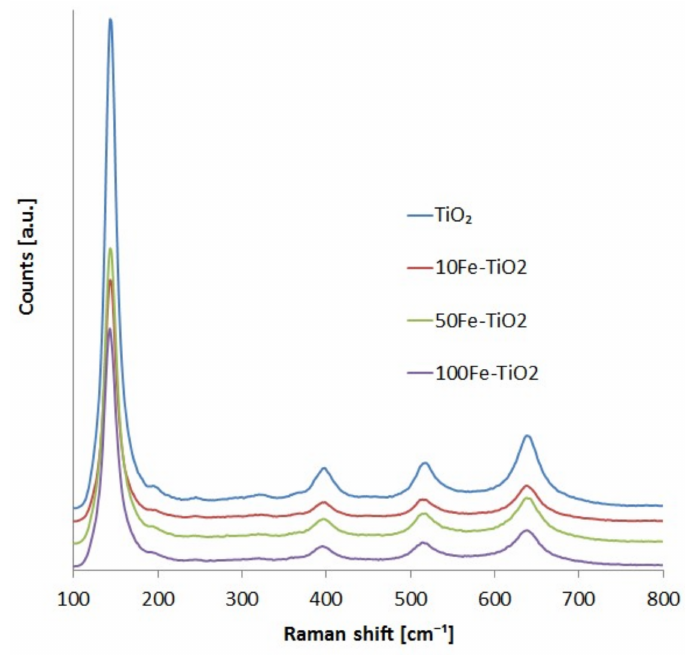
Figure 4. Raman spectra of undoped and Fe-doped TiO 2 photocatalysts in the range of 100–800 cm − 1